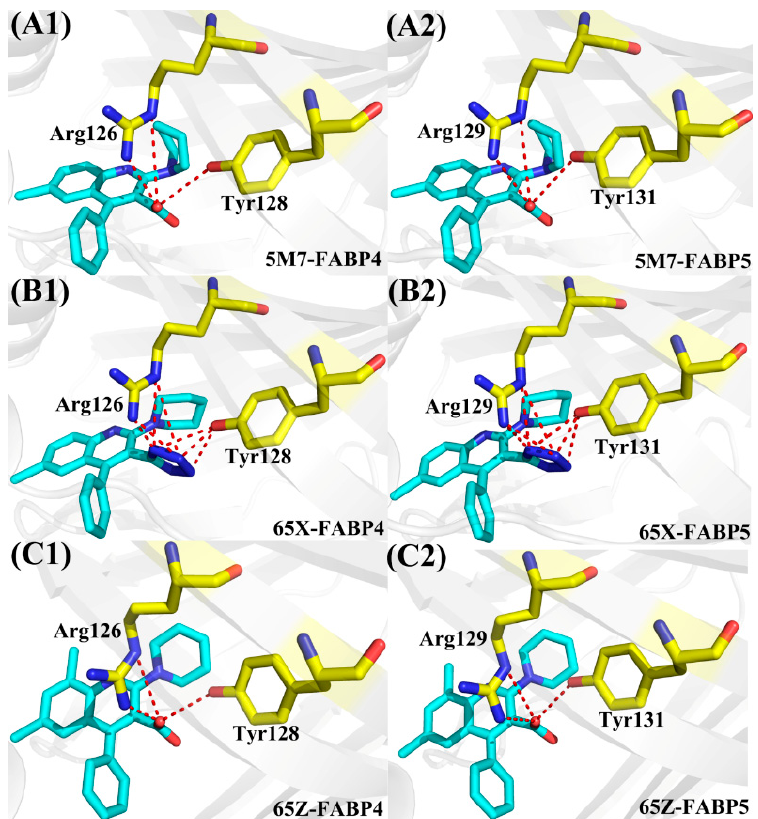
Figure 5. Geometric positions of inhibitors relative to the key residues involving significant interactions, the averaged distances between atoms involving significant interactions were calculated and displayed in the red lines. ( A1 / A2 ) 5M7-FABP4/FABP5; ( B1 / B2 ) 65X-FABP4/FABP5; and ( C1 / C2 ) 65Z-FABP4/FABP5. All inhibitors and key residues in inhibitor-FABP4/5 complexes are separately shown in light blue and yellow.